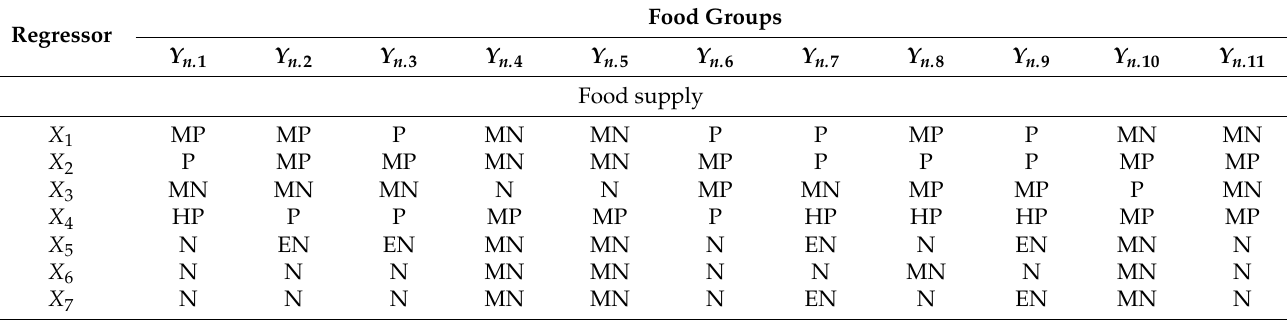
Table 9. The effects of X n on Y n in upper-middle-income